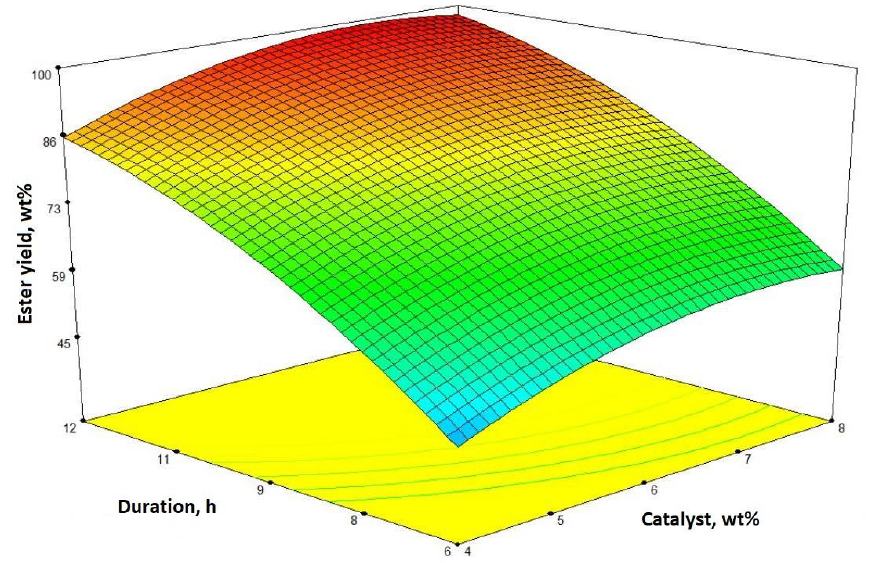
Figure 3. The interaction between the process time and the catalyst content for the ester yield (the butanol-to-oil molar ratio is 12:1) presented by a response surface contour plot.